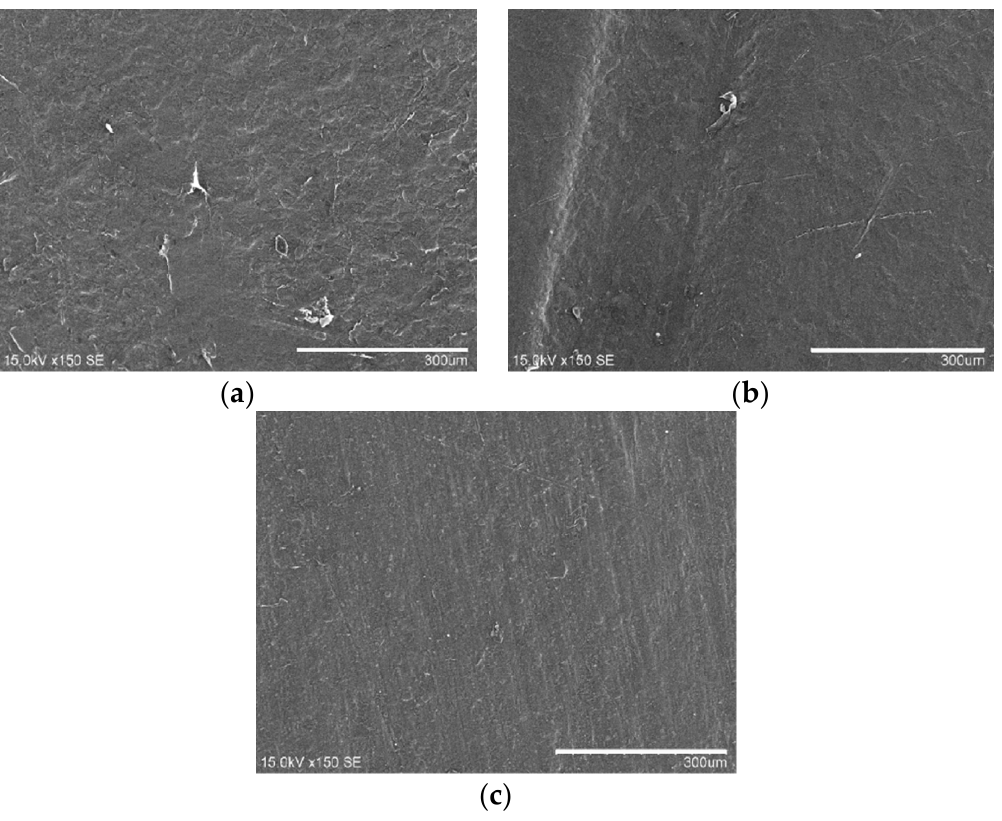
Figure 14. SEM diagram of PTFE wear surfaces filled with different carbon materials: ( a ) 1% 7 μm CF; ( b ) 1% 200 nm CF and ( c ) 1% MWCNT.